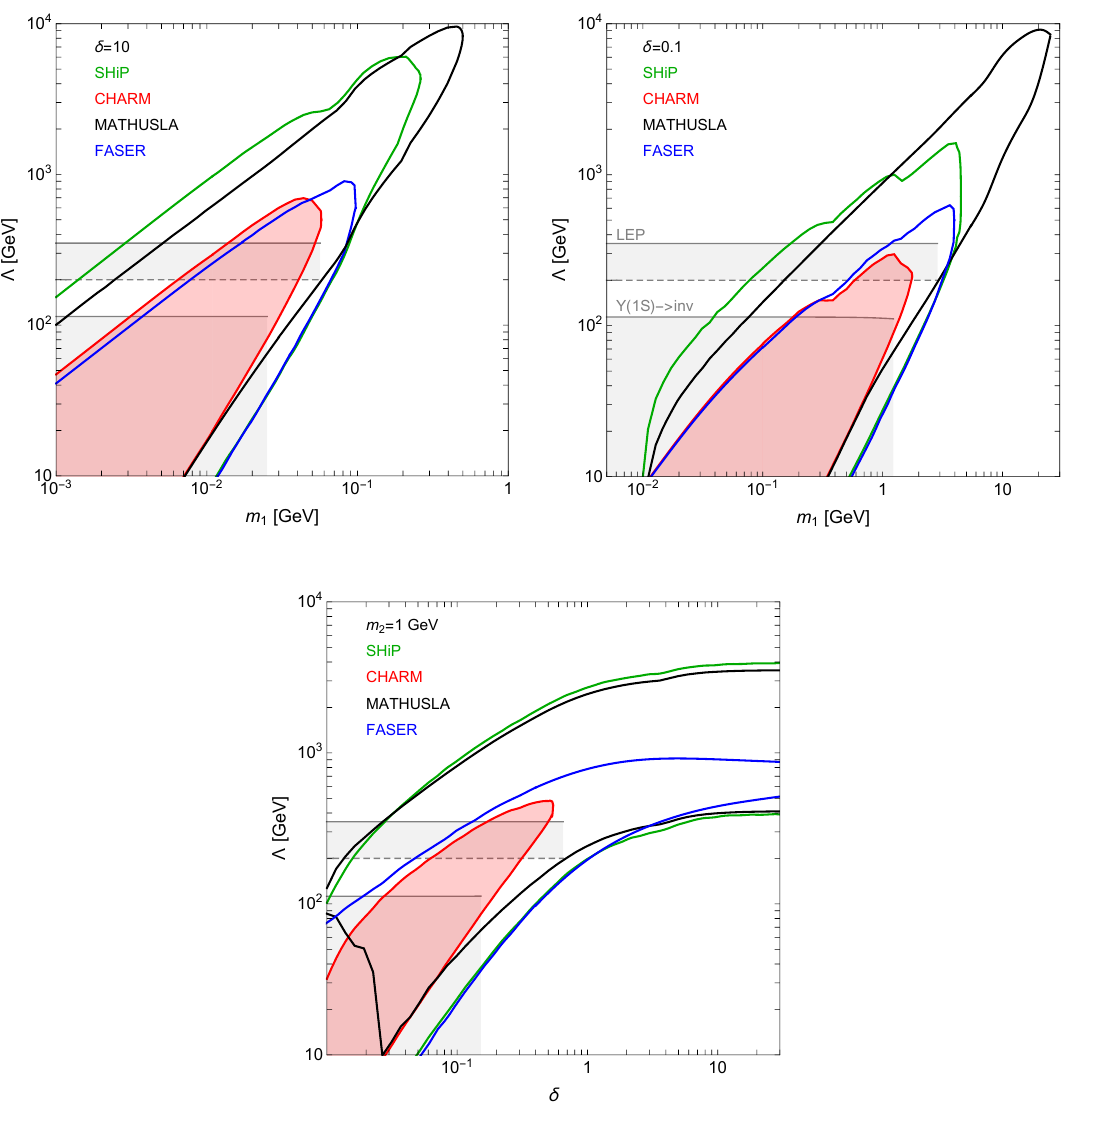
Figure 4 . 90% CL exclusion limits of the CHARM experiment, and projected sensitivities of the SHiP, MATHUSLA and FASER experiments to the scale Λ of EFT operators in eq. (1.7). In the top panel the sensitivity reaches are shown as a function of the mass m 1 of the lightest dark scalar. Left (right) panel is for a mass splitting δ = 10 ( δ = 0 . 1 ). In the bottom panel the sensitivities are presented as a function of the mass splitting between the dark scalars, and for a mass of the heaviest one of m 2 = 1 GeV. In all panels we take c f = c f = 1 . Gray regions are excluded by the L R constraints discussed in section